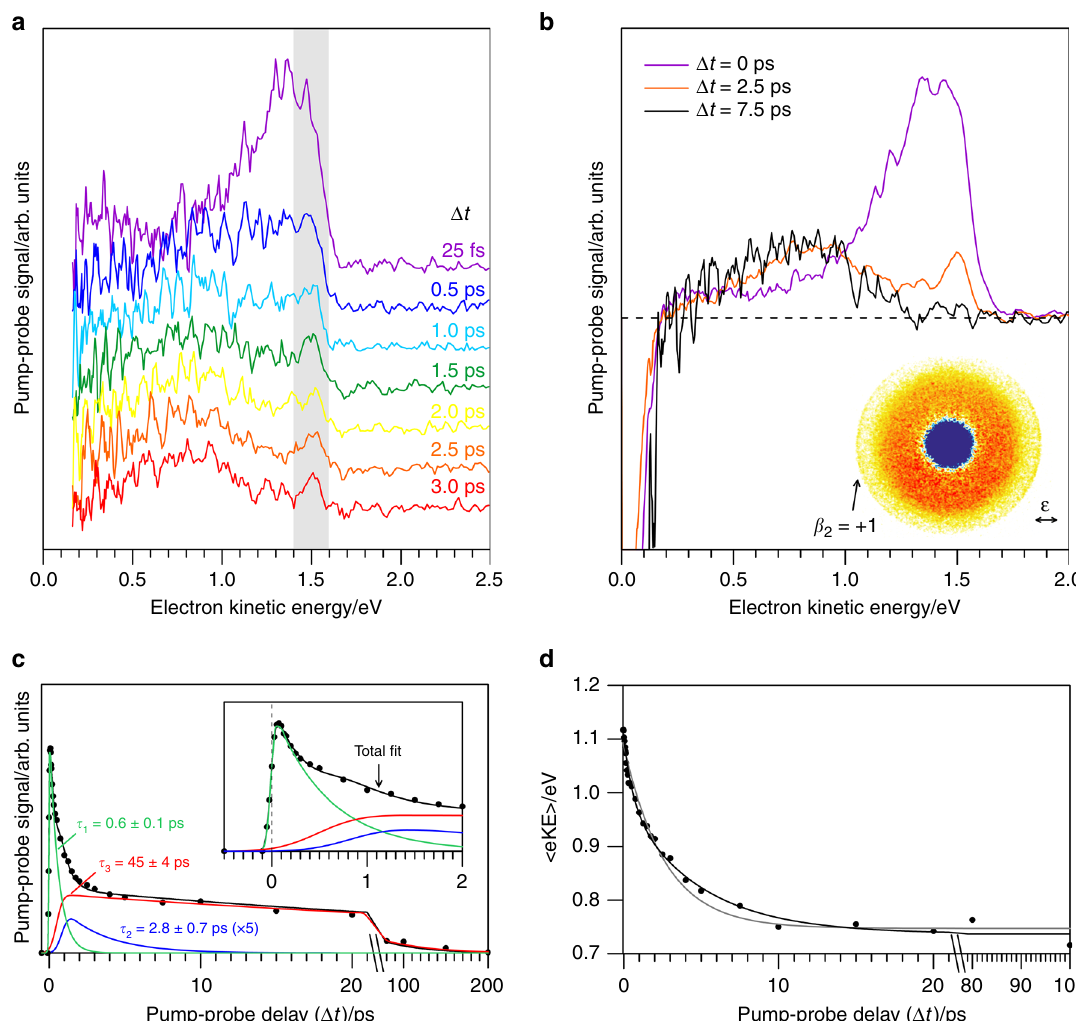
Fig. 2 Time-resolved dynamics in p CEs − following excitation of the S 1 ( ππ *) state at 2.83 eV. a Waterfall plot of the time-resolved spectra over the fi rst 3 ps, in 0.5 ps increments. Grey shading highlights evolution of the dipole-bound state. b Example time-resolved spectra taken with higher signal-to-noise than a . The Δ t = 2.5 ps spectrum illustrates the sharp, high-eKE feature associated with the DBS. The corresponding velocity-map is shown in the inset, with ε indicating the femtosecond pump and probe pulse electric fi eld polarisation. c Total time-resolved signal with Δ t and kinetic model fi t, τ 1 = 0.6 ± 0.1 ps, τ 2 = 2.8 ± 0.7 ps, and τ 3 = 45 ± 4 ps. d Average time-resolved electron kinetic energy with Δ t , which is best fi t with two lifetimes (black trace), τ 1 ′ ≈ τ 1 and, τ 2 ′ = 4.7 ± 0.5 ps ≈ τ 2 + 1.4 ps, with 1.4 ps being the Δ t for maximal DBS signal. The grey trace is a single-exponential fi t, which is visually The fraction of excited state population that remains in the S 1 ( ππ *) state, which is shown by the Δ t = 7.5 ps spectrum in Fig. 2b, decays with a lifetime of τ 3 = 45 ± 4 ps. The broad spectral shape and the maximum eKE of this time-resolved fea- ture indicates a valence state with electron-binding energy, eBE = 1.55 – 0.75 eV ≈ 0.8 eV, consistent with detachment from the valence-localised S 1 ( ππ *) state along some nuclear displacement away from the Franck-Condon region. The relatively long lifetime of this time-resolved signal combined with the absence of spectral evolution suggests that the S 1 ( ππ *) population becomes trapped in a potential energy minimum that is presumably associated with a twisted intermediate (phenyl group and alkene tail twisted by 90°) as predicted by theory 8,9 . In principle, this signal could also arise from the lowest triplet state of the anion. However, the triplet state has not been invoked in previous experimental or computational work and would not be consistent with the observed photoisomerisation of the chromophore in PYP or coumaric acid anions in solution. The twisted intermediate decays through vibrational autodetachment since the time-resolved